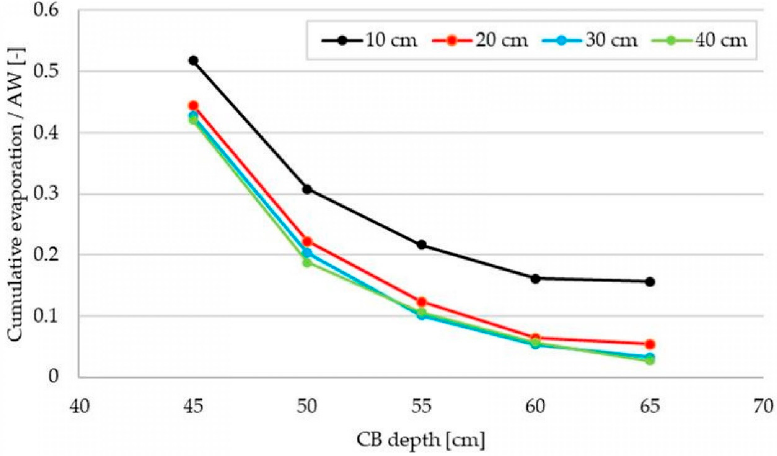
Figure 6. Cumulative evaporation expressed as a fraction of AW during the 28-day simulations when the ring-shaped emitter and CB are at different depths. The results for different ring-shaped emitter depths (10, 20, 30, and 40 cm) are shown using lines of different colors.